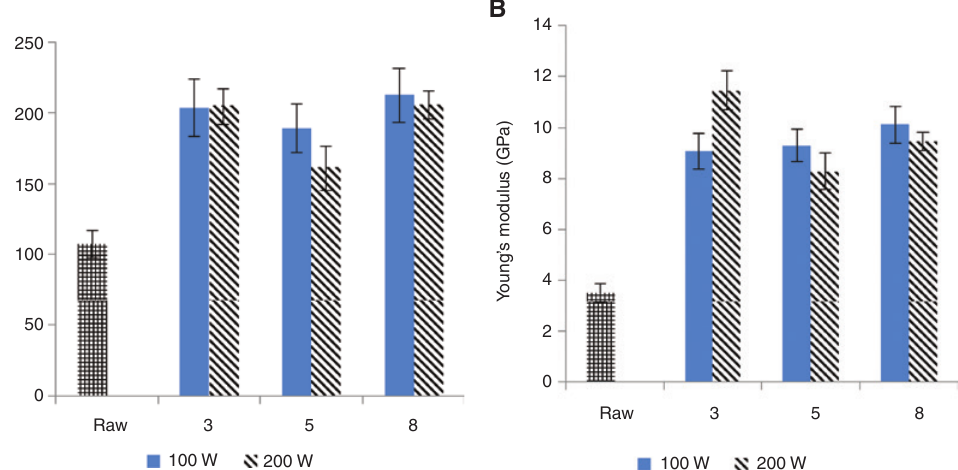
Figure 8: Treatment conditions: two discharge powers (100 W and 200 W) and three exposure times (3, 5 and 8 min). (A) Tensile strength and (B) Young’s modulus of treated and untreated DPFs.